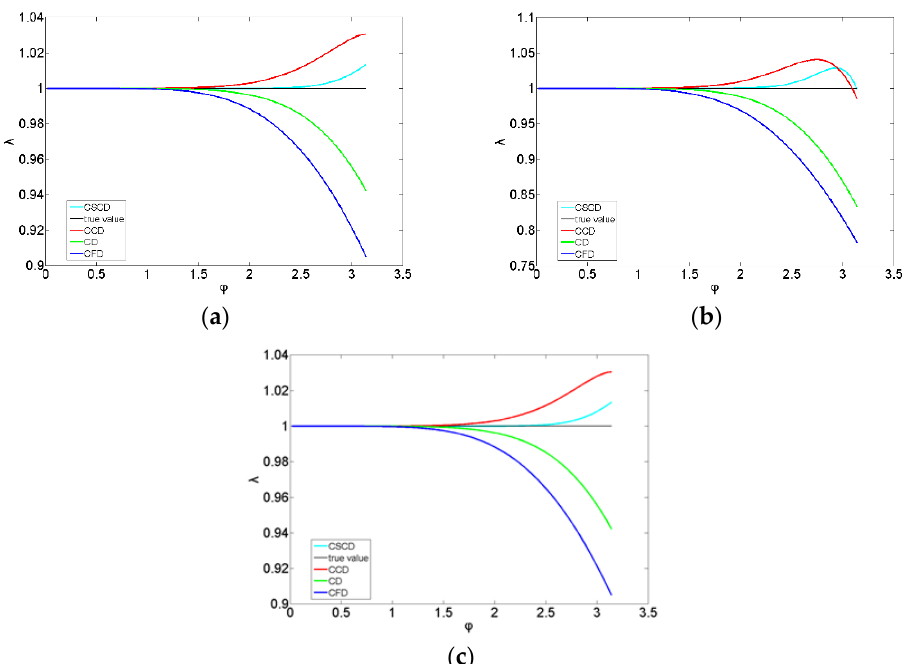
Figure 1. Velocity ratio curves for different numerical simulation methods. The blue curve is the traditional central difference scheme, the green curve is the traditional implicit difference scheme, the red curve is the CCD difference scheme, the blue curve is the CSCD difference scheme, and the black line is the velocity ratio constant of 1: ( a ) θ = 0, α = 0.25; ( b ) θ = π /6, α = 0.25; ( c ) θ = π /3, α =